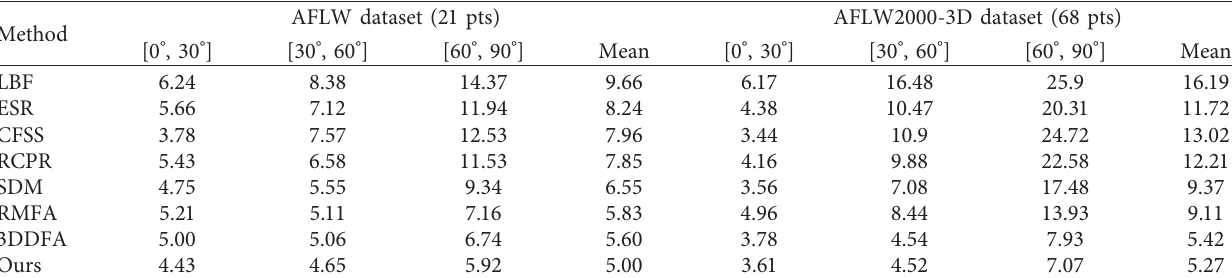
Table 2: Face alignment algorithm results comparison.